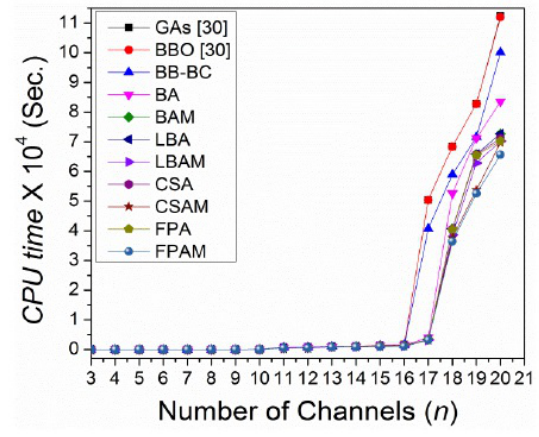
Figure 7: Performance comparison of proposed algorithms in terms of computational